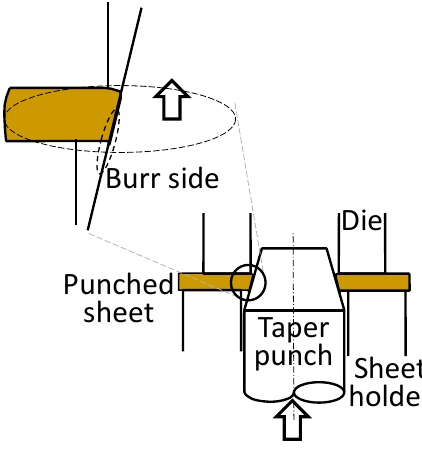
Figure 5. Ironing process of punched edge with taper punch [37].